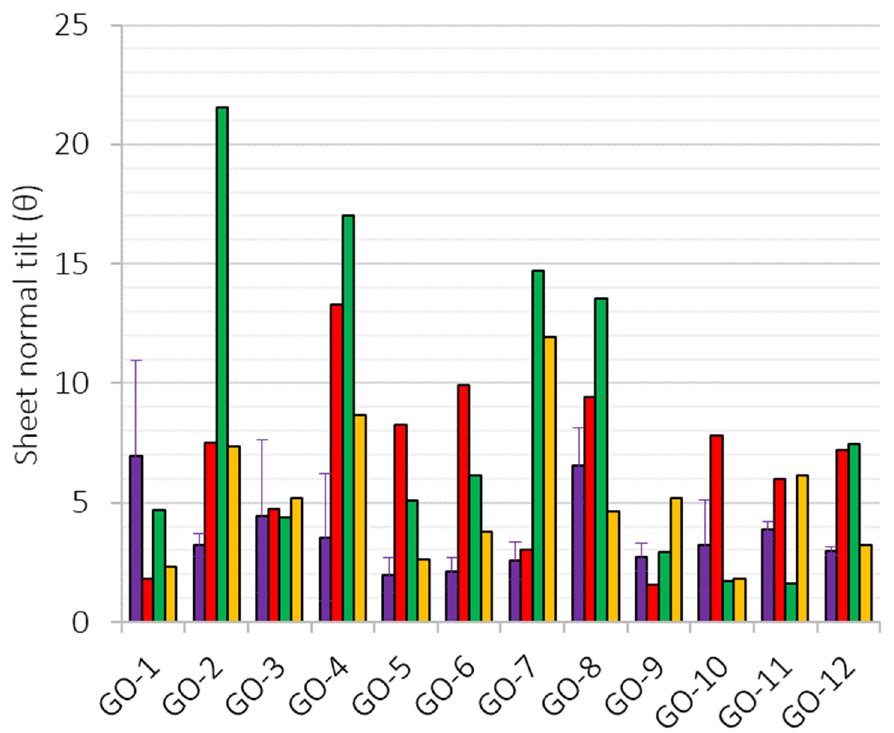
Figure 7. GO sheet tilt angle with respect to normal axes: GO in water (red), GO-PAI (purple), GO-PVDF (green), and GO-PAI-cr (yellow). We investigated the stability in water of GOs supported on different polymeric films using molecular dynamics simulations. The membranes consisted of three layers of GOs deposited onto the hydrophobic and hydrophilic polymeric supports. We